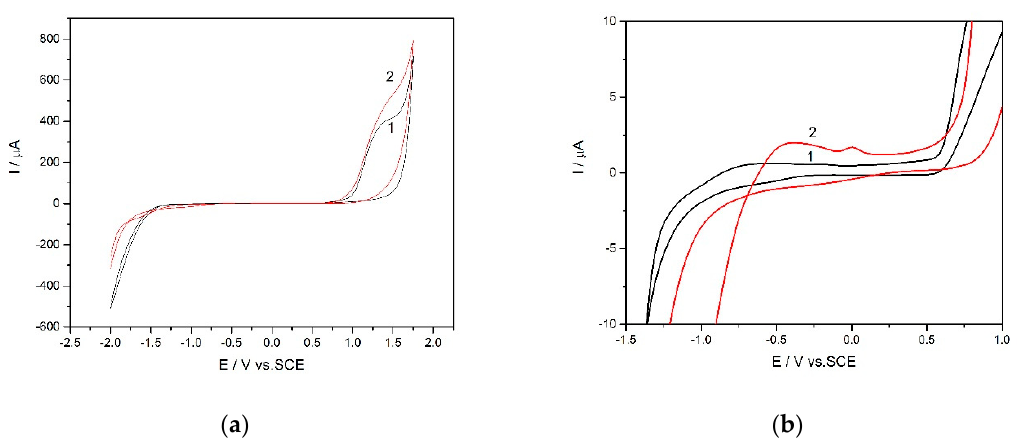
Figure 8. ( a ) Cyclic voltammetry recorded at an unmodified BDD electrode (curve 1) and LaFeO 3 / BDD electrode (curve 2) in 0.1 M NaOH supporting the electrolyte, scan rate of 0.05 Vs − 1 . ( b ) Detail of cyclic voltammetry recorded at an unmodified BDD electrode (curve 1) and LaFeO 3 / BDD electrode (curve 2) in 0.1 M NaOH supporting electrolyte. Materials 2020 , 13 , x FOR PEER REVIEW 12 of 18